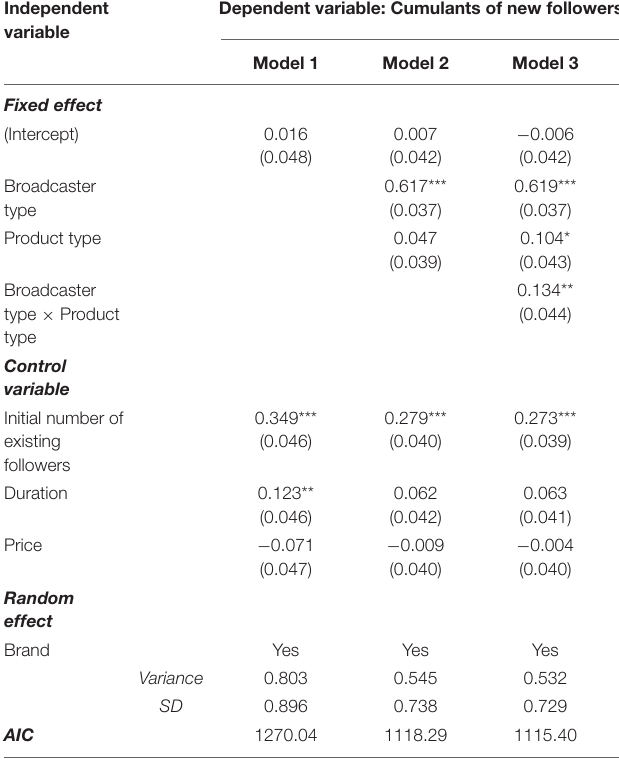
TABLE 3 | Regression